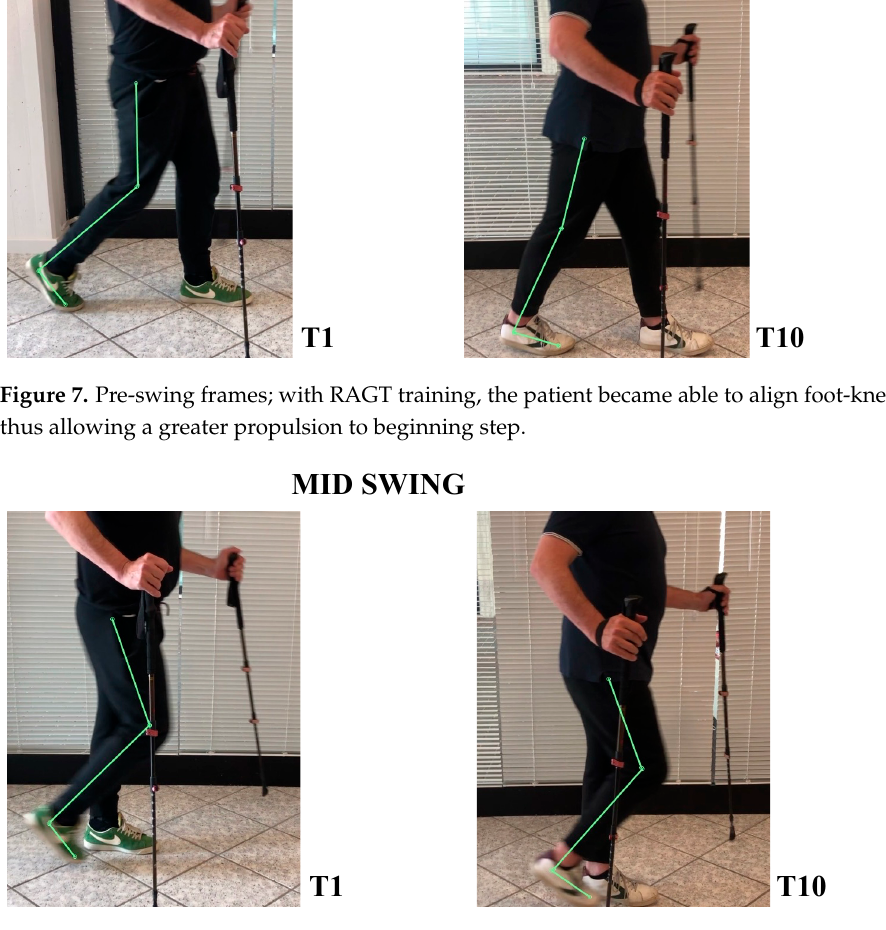
Figure 8. Mid-swing frames between initial and final evaluation. It is possible to see, during limb advancement, a better alignment in flexion, with a lower ankle angle to the ground. This improvement allowed the patient to walk with safety in everyday life.